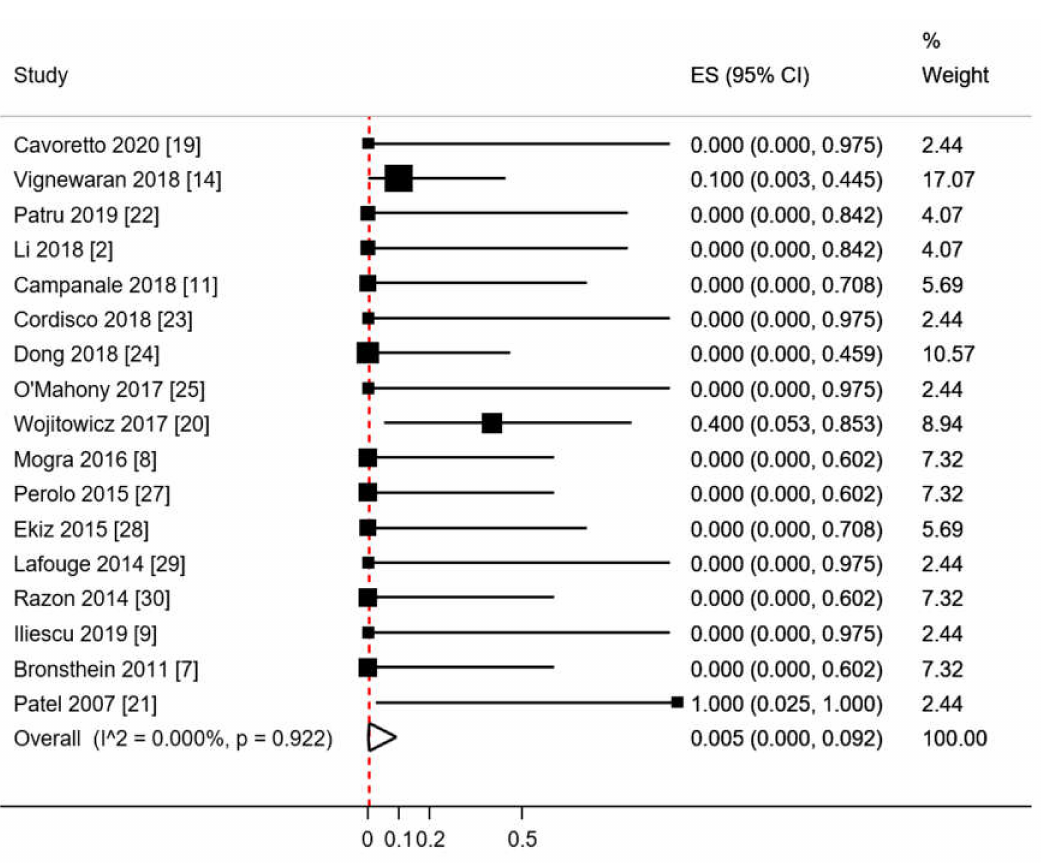
Figure 4. Pooled proportion of extracardiac abnormalities in RAA / RDA fetuses. ES: e ff ect size. CI: confidence interval. Red dashed line describes the e ff ect estimate found in the present analysis. Iˆ2: I 2 of